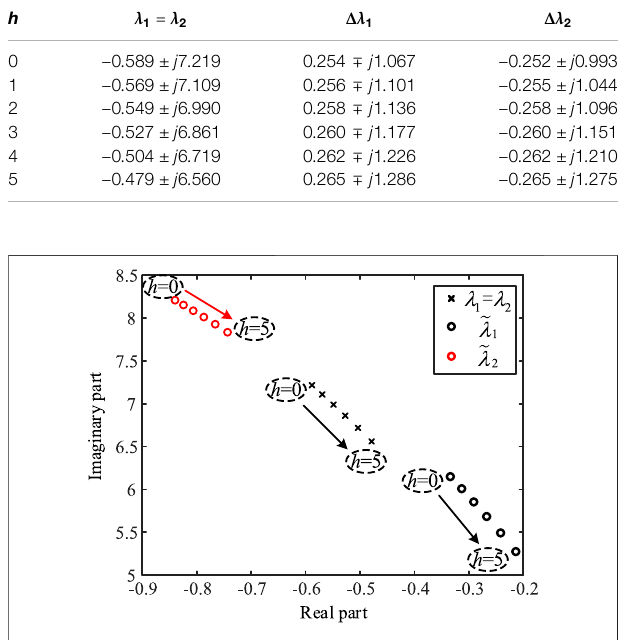
FIGURE 9 | Trajectories of open and closed-loop mode with increasing electrical distance between the PV